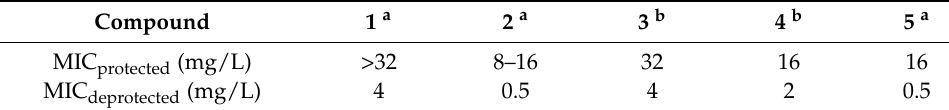
Table 2. Minimum Inhibitory Concentration (MIC) values of photoreleasable quinolones before and after irradiation.